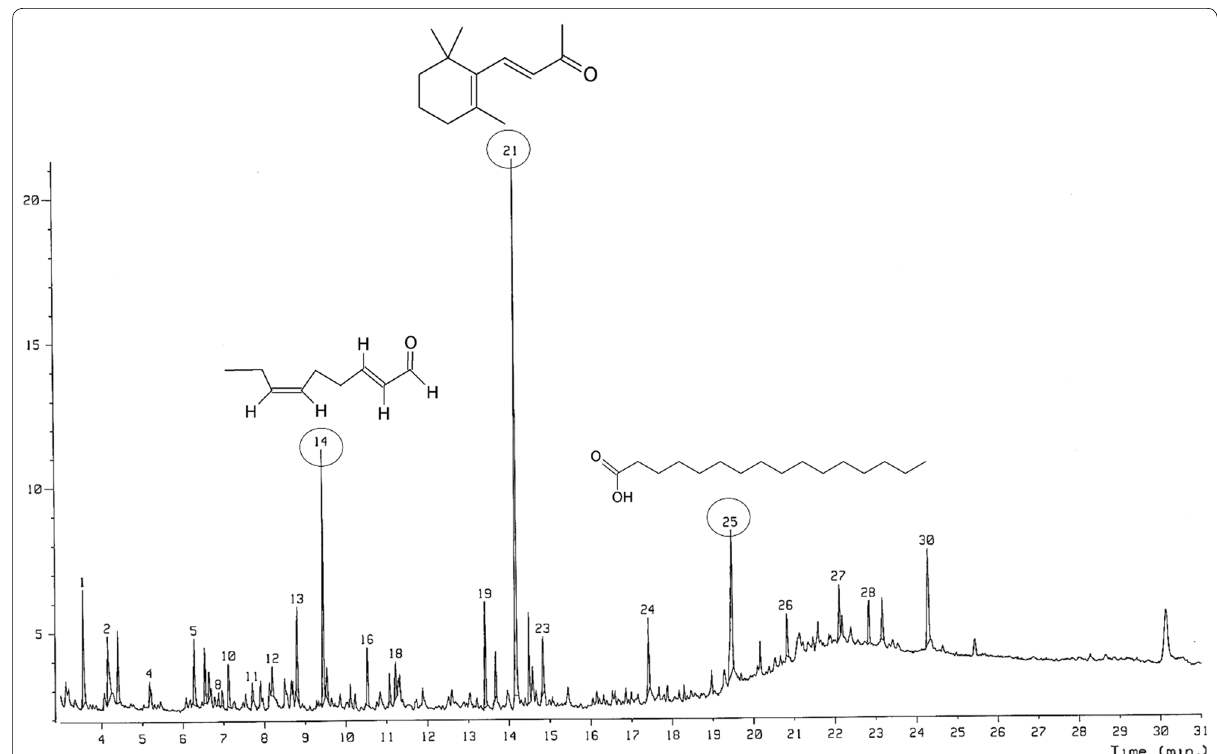
Fig. 1 GC–MS spectra of Porphyra tenera volatile oil and the chemical structure of three dominant compounds